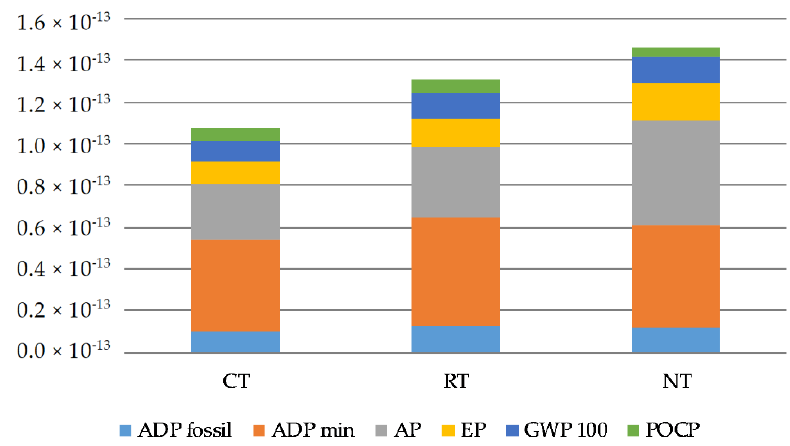
Figure 5. Aggregated environmental indicator values: abiotic resources depletion potential for fossil fuels (ADP fossil), abiotic resources depletion potential for minerals (ADP min), acidification potential (AP), eutrophication potential (EP), global warming potential (GWP 100), photochemical ozone creation potential (POCP) per 1 kg of grain in winter wheat production for different tillage systems.